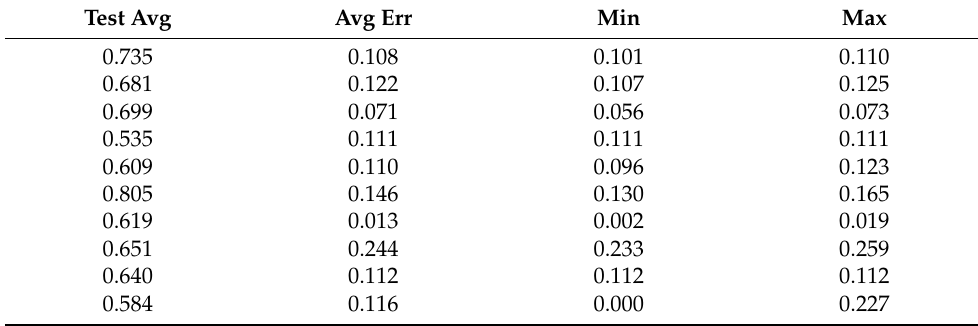
Table A132. Set 2, trials 31–40 data (average actual PR values).